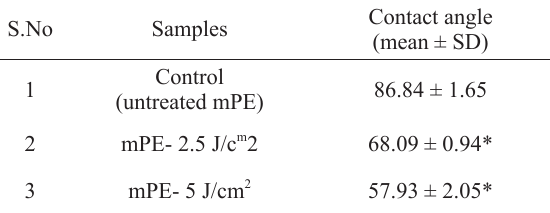
Mean contact angles of the mPE, mPE-2.5 J/cm 2 and mPE-5 J/cm 2 treated samples (*mean differences were significant compared with untreated mPE (p< 0.05)).